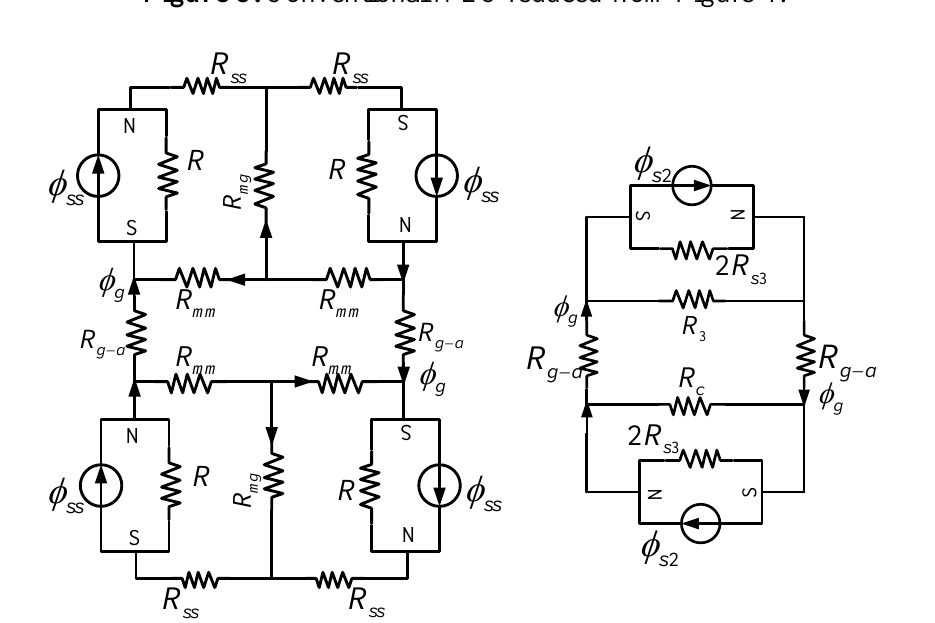
Figure 5. Conventional MEC reduced from Figure